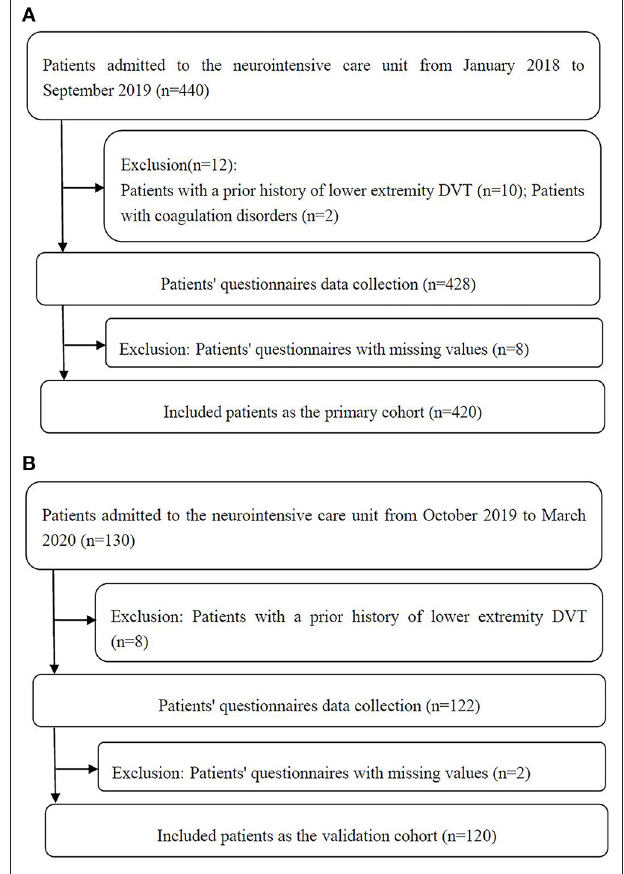
FIGURE 1 | Flowchart of the primary cohort (A) and validation cohort (B)